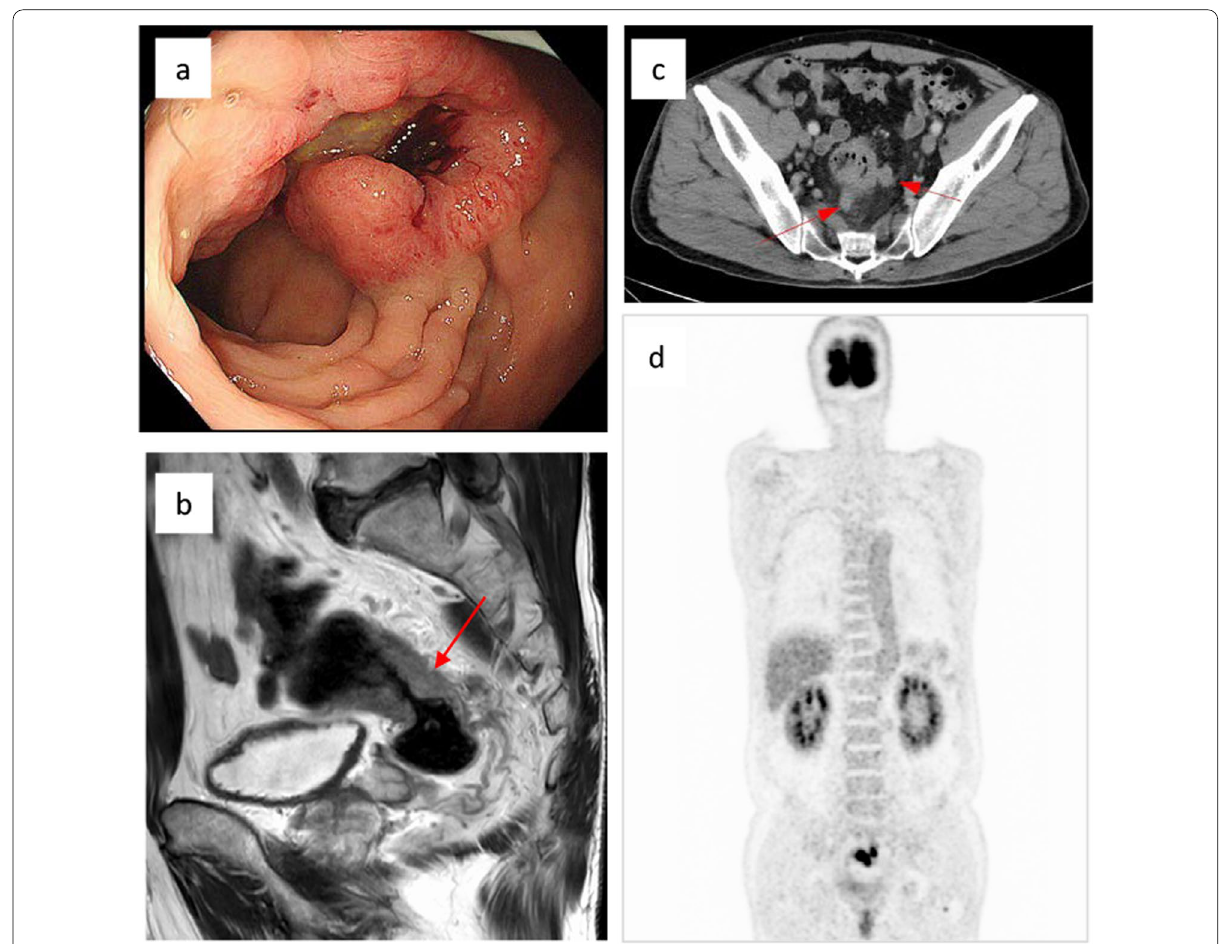
Fig. 3 Preoperative image of rectal cancer. a Subcircumferential type 2 advanced carcinoma in the lower rectum. b Mid-sagittal plane of magnetic resonance imaging analysis of rectal cancer. c Abdominal computed tomography (CT) scan of circumferential wall thickening of the rectum and advanced metastasis to regional lymph nodes. d Positron emission tomography–CT showed no other obvious distant